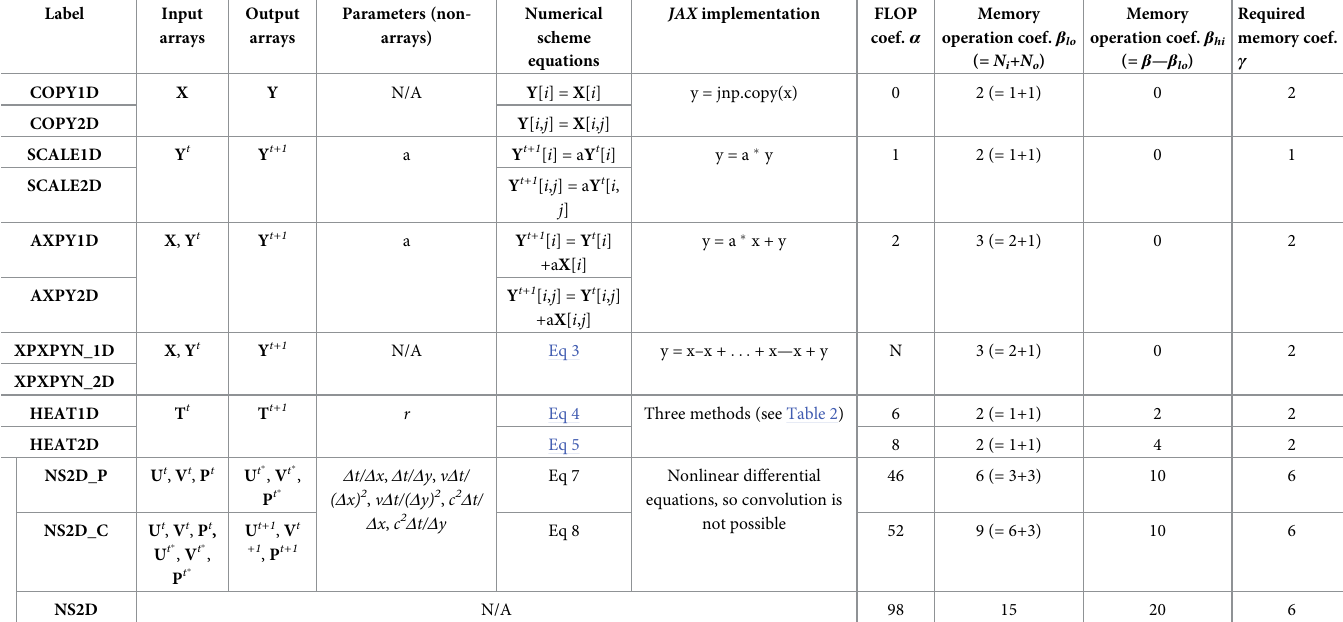
Table 1. The examined